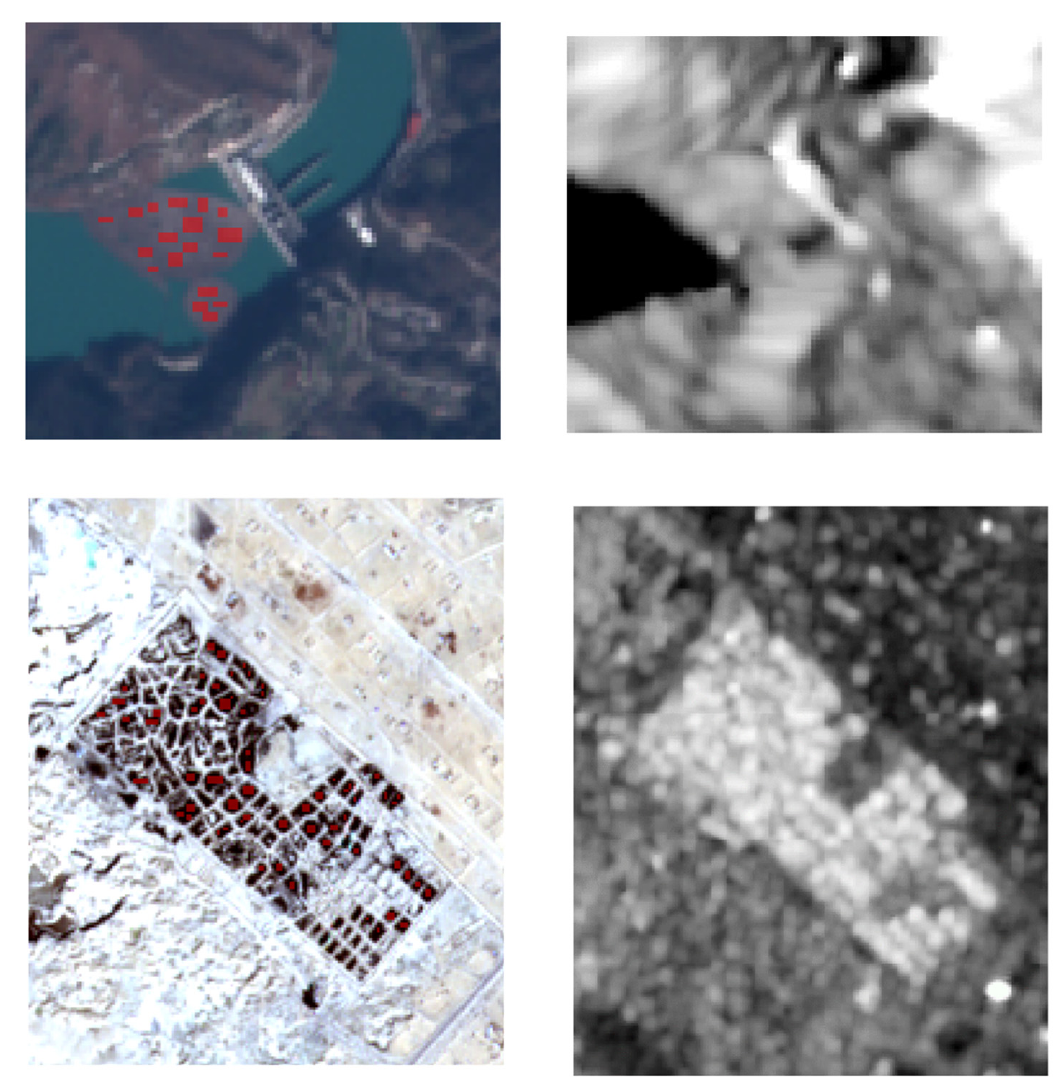
Figure 3. Example of pixels being digitized for the Višegrad Dam aquatic site ( top ) and tyre grave- yard in Kuwait ( bottom ) as the Sentinel-2 pseudo-true colour ( left ) and SAR backscatter image ( right )—digitized polygons are coloured red.